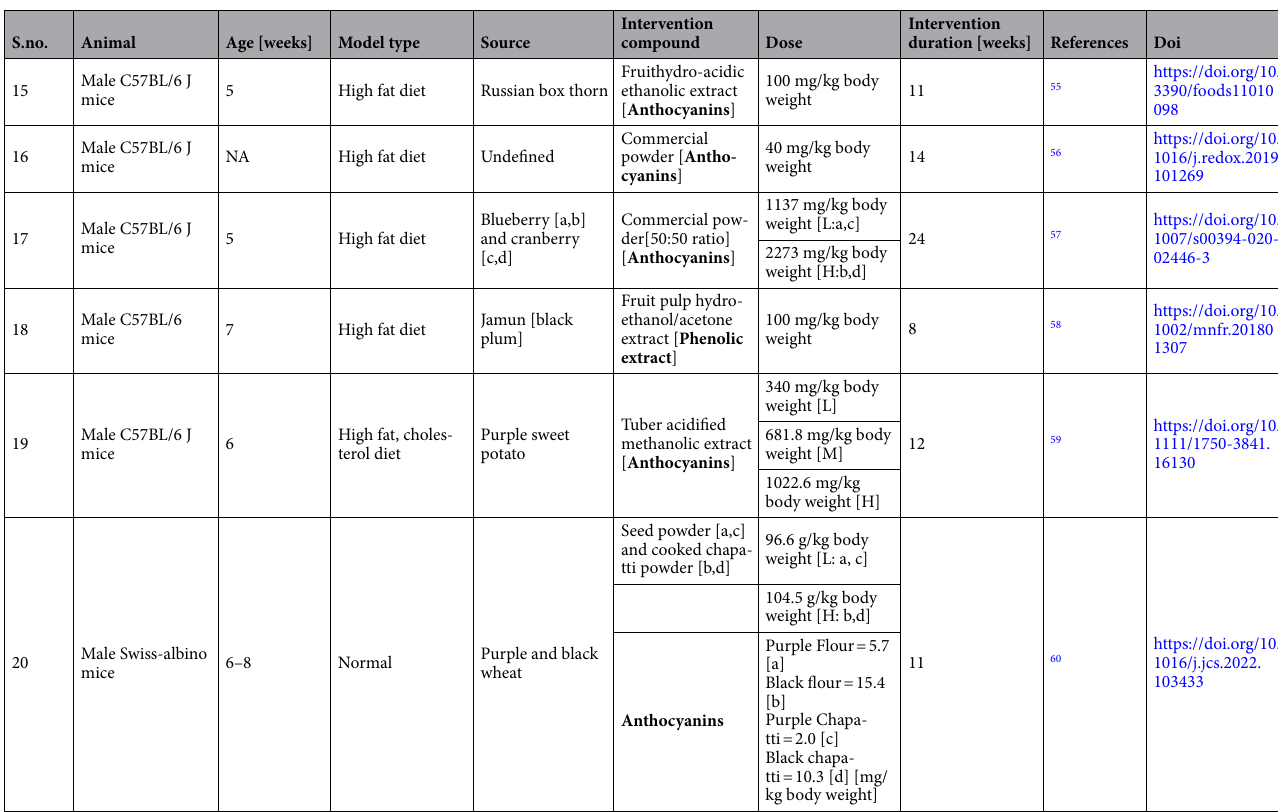
Table 1. Characteristics of the studies used to investigate the effect of anthocyanins on the Fir/Bac ratio. # For understanding the effect of dose, different interventions given to animals were uniformalised to mg/kg body weight. For dose conversion in mg/kg of body weight, the average weight and diet considered for mice were 22 g and 2.5 g, and for rats were 200 g and 11 g,